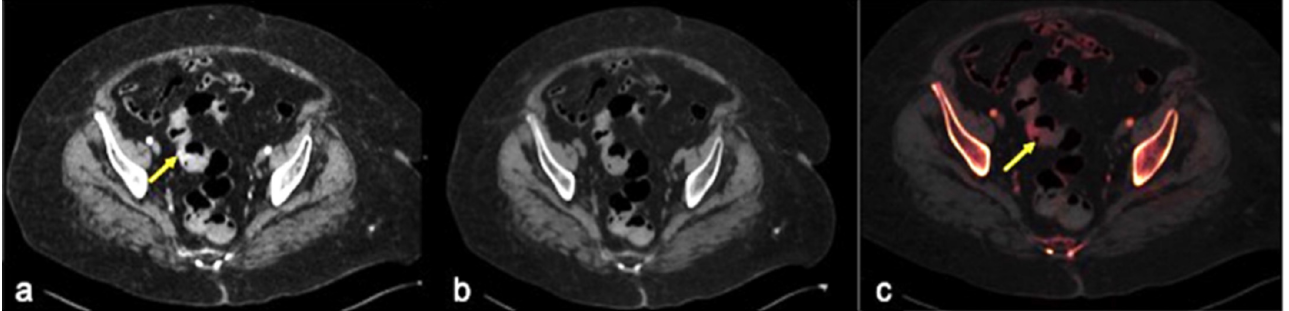
Figure 7. DECTA multiphasic study of a haemorrhagic spot in the middle sigmoid tract. In the arterial phase ( a ) an area of active bleeding is visible (arrow). In the virtual non-contrast post-processed axial image ( b ), it is possible to realise a selective subtraction of the contrast media density in order to obtain an image similar to the pre-contrast acquisition. In the iodinated distribution map of arterial phase ( c ), the blush of active bleeding is easily identified (arrow).